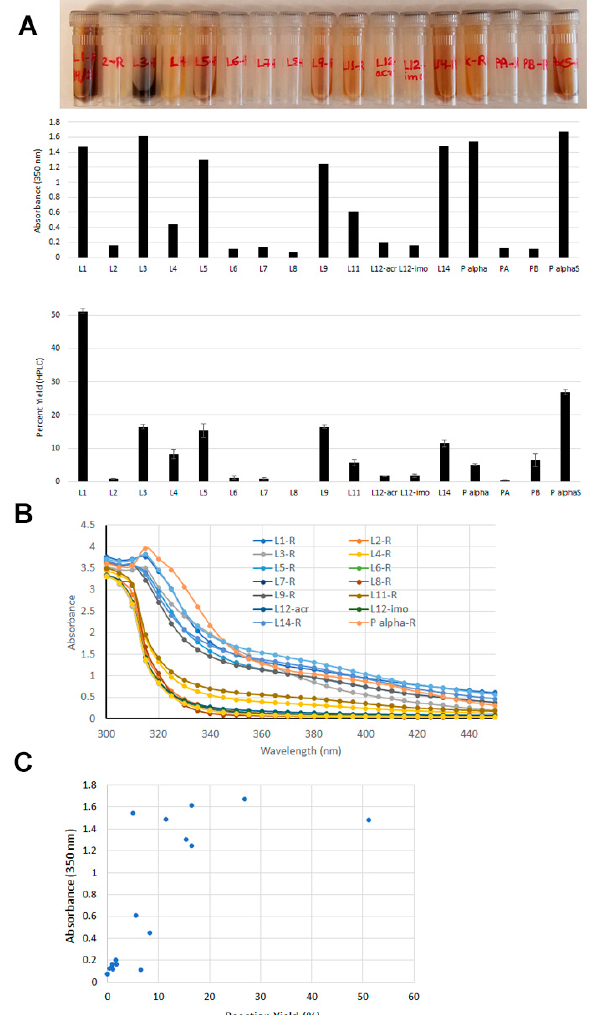
Figure 6. Rescreening of the lipase library under optimized conditions. ( A ) Images of reactions after 89 h (top); absorbance of crude reaction mixtures at 350 nm (middle); and reaction yields from rescreening of each the lipase library (bottom). Error bars determined from three replicate HPLC injections. ( B ) Wavelength scan of crude reaction absorbance. ( C ) Plot of absorbance (350 nm) versus reaction